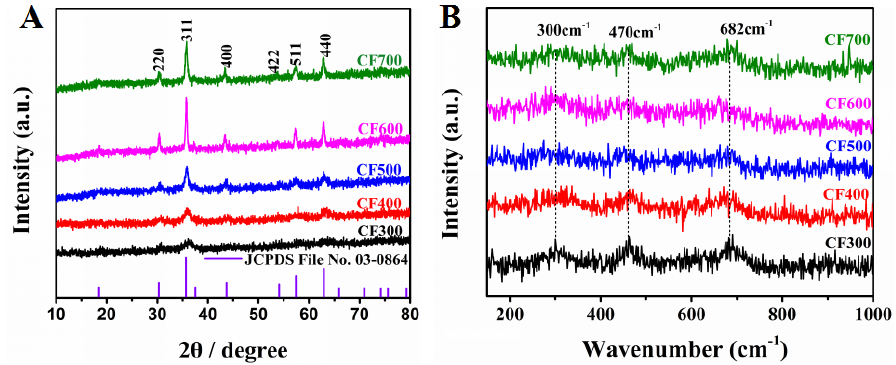
Figure 1. ( A ) XRD patterns and ( B ) Raman spectra of CoFe 2 O 4 prepared at different temperatures.